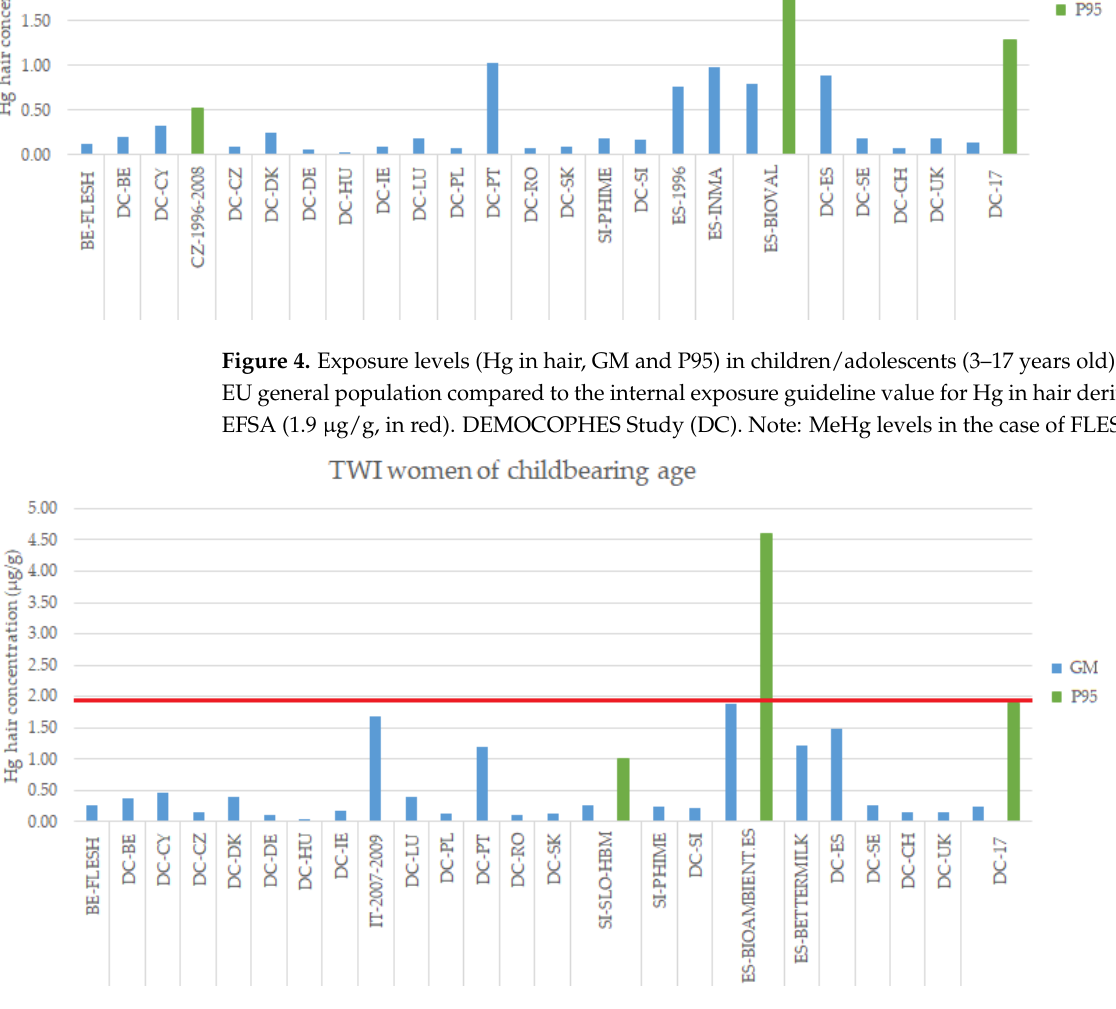
Figure 5. Exposure levels (Hg in hair, GM and P95) in women of childbearing age (18–50 years old) from the EU population compared to the internal exposure guideline value for Hg in hair derived from EFSA (1.9 µg/g in red). DEMOCOPHES Study (DC). Note: MeHg levels in the case of FLESH and Valent et al., 2013 studies.